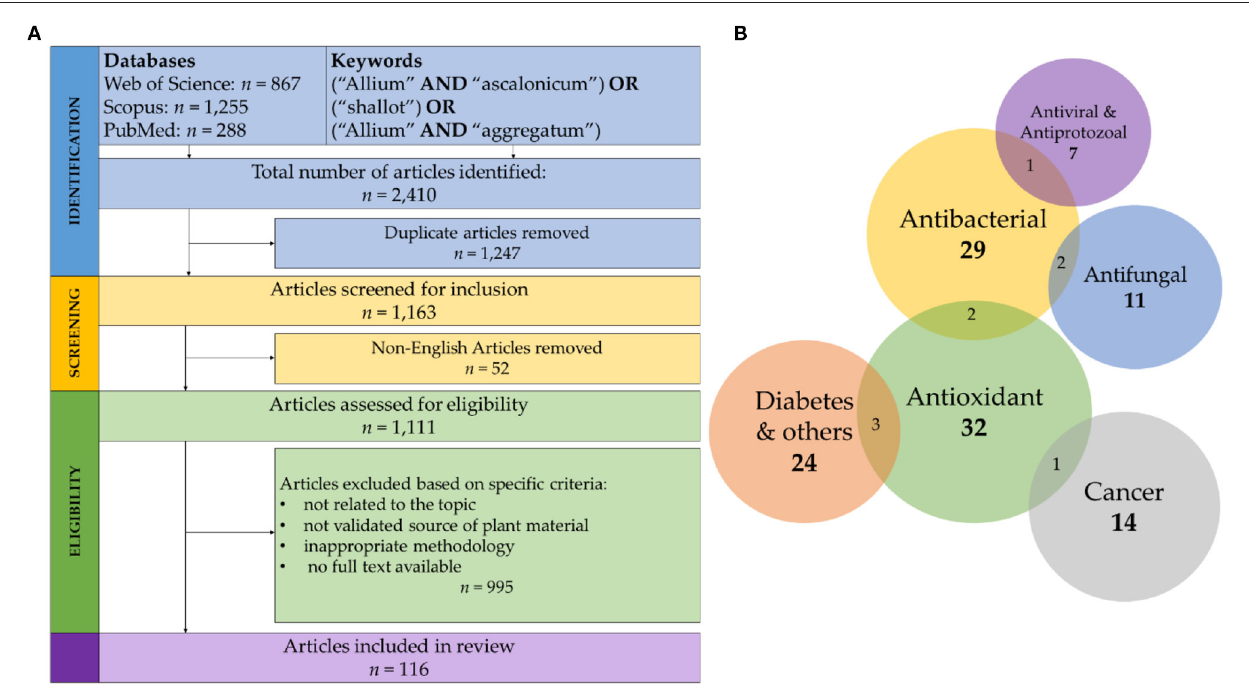
FIGURE 1 | (A) Representation of inclusion and exclusion criteria, with corresponding results from the literature search used. (B) Venn Diagram of type and number of studies included in this review. The overlapping zones and the associated numbers correspond to number of articles which describe two or more pharmacological